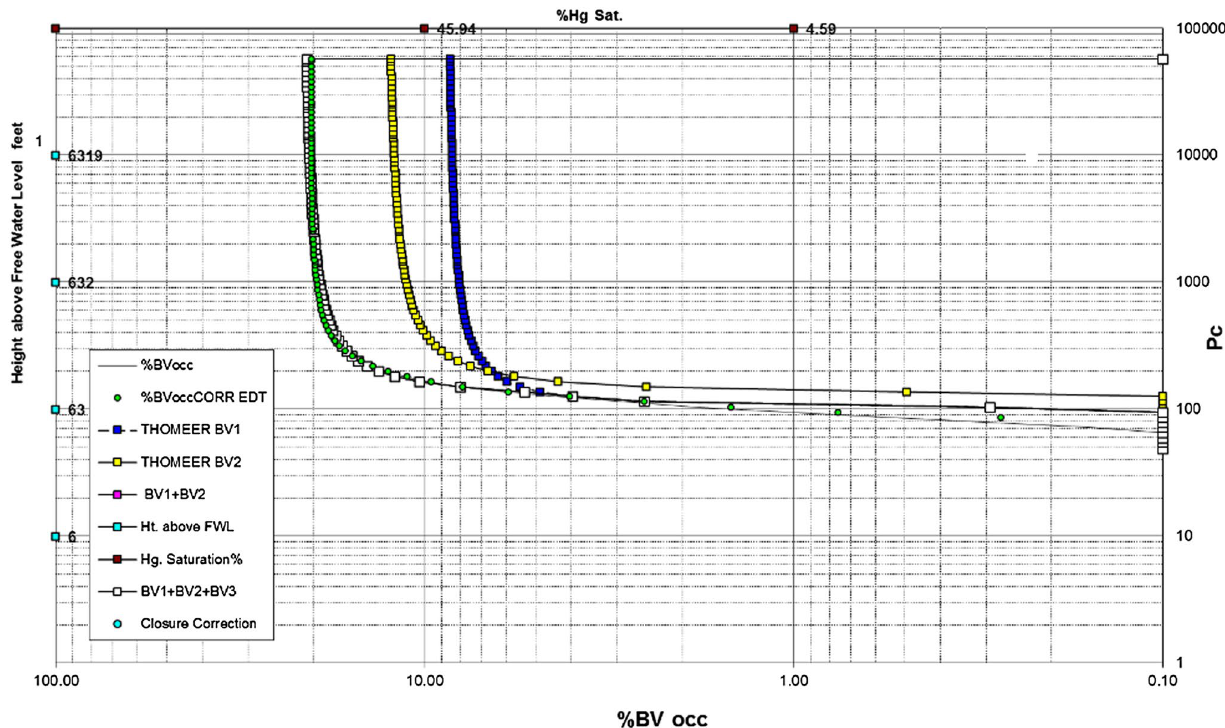
Fig. 3 Thomeer hyperbola matching using Clerke spreadsheet where two hyperbolas (blue and yellow) represent different pore system to match the MICP